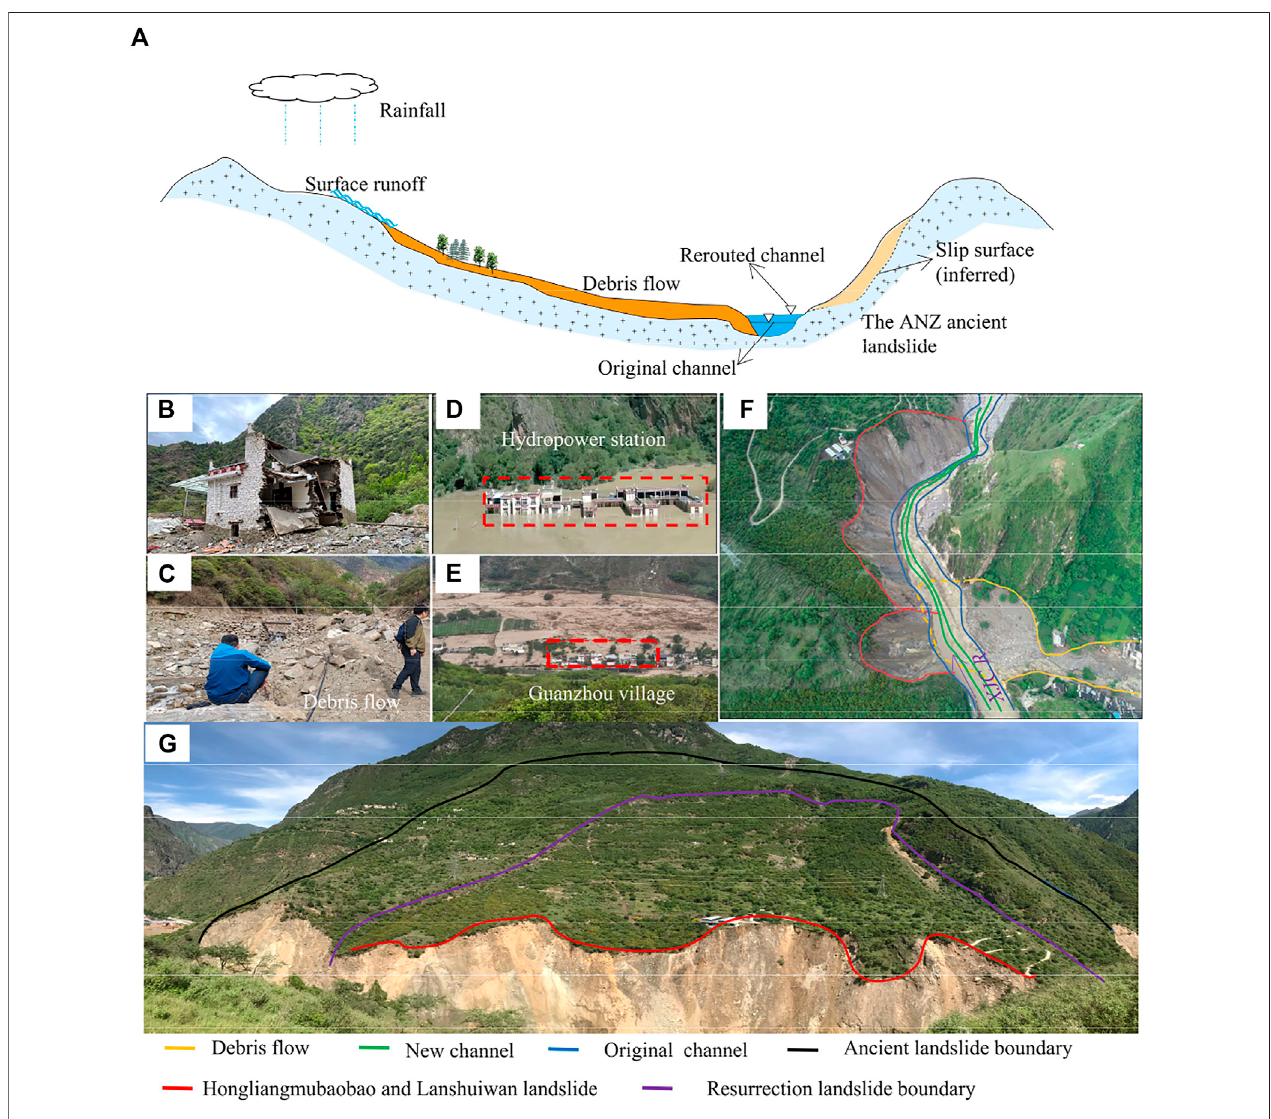
FIGURE 2 | Multi-hazard chain caused by the Meilong debris fl ow. (b – g) On-spot photos and unmanned aerial vehicle (UAV) images taken in the fi eld survey. (A) Schematic of the multi-hazard process; (B,C) houses destroyed by the debris fl ow and debris- fl ow deposits in the Meilong channel; (D,E) the dammed lake and Guanzhou village damaged by the fl ood; (F,G) the ancient ANZ